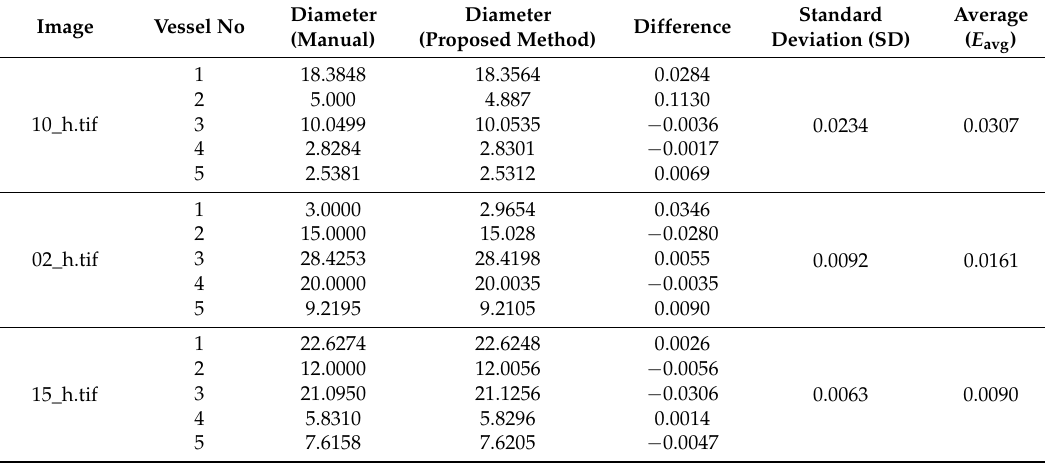
Table 2. Comparison of the diameter measurements (in pixels) between the proposed method and manual method for the High-Resolution Fundus (HRF) Image